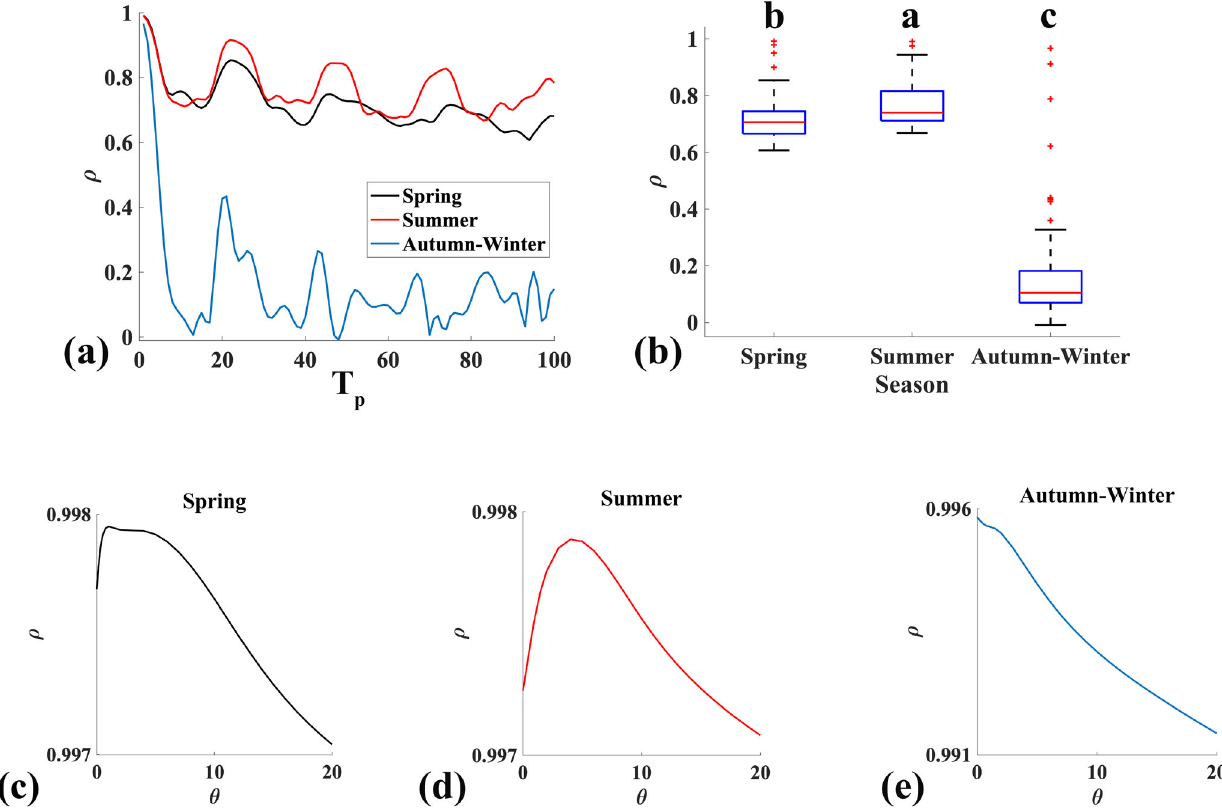
Fig. 4 Seasonal variation of predictability and dynamics of the sound pressure level. a Prediction pro fi le depicting prediction skill (p) vs. prediction interval ( T p ) during spring, summer, and autumn-winter seasons. b Comparison of prediction skills during spring, summer, and autumn-winter; n = 100 predictive skill replicates per group. Each box with a superscript letter represents the results from a post hoc multiple comparison test. In each box, the central red mark depicts the median, and the top and bottom edges of the box represent the 25th and 75th percentiles. The maximum and minimum values are marked in black at the extreme ends. Whiskers and Lines (black) delineate 95% con fi dence intervals. The symbol ‘ + ‘ represents outliers. Different superscript letters indicate signi fi cant differences ( p < 0.05), with the letter ‘ a ’ at the top and subsequent statistical differences are represented at a lower level. c – e Dynamics pro fi le depicting prediction skill (p) vs. nonlinearity ( θ ) during spring, summer, and autumn-winter